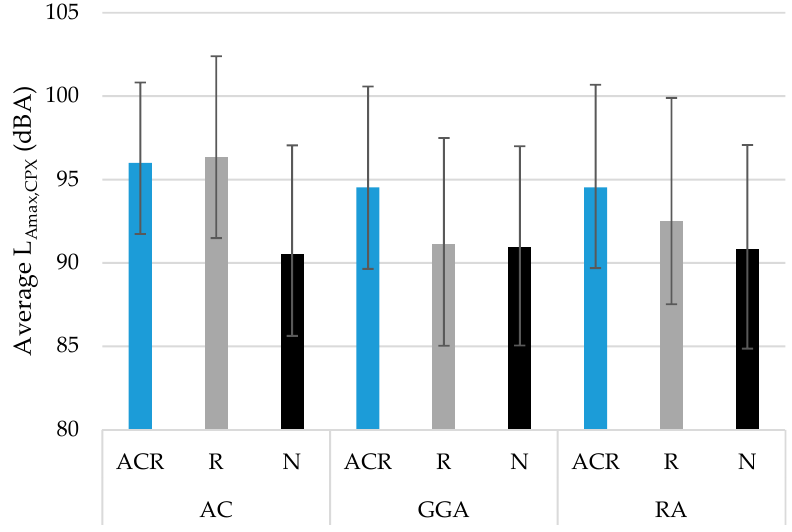
Figure 6. Average L A max,CPX for all speed levels for the pavement and distress type. The range is shown as an error bar.